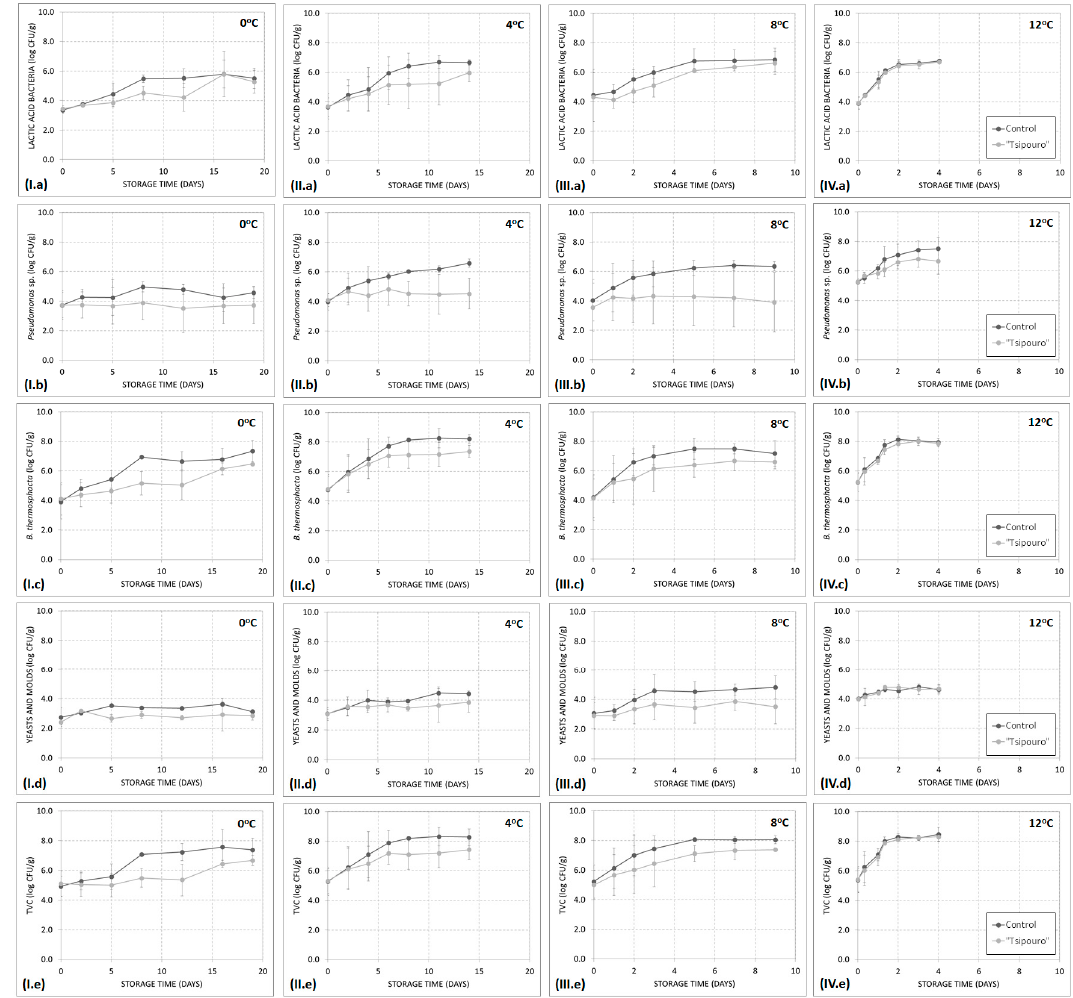
Figure 3. Growth curves of ( a ) LAB, ( b ) pseudomonads, ( c ) B. thermosphacta , ( d ) yeasts and moulds,